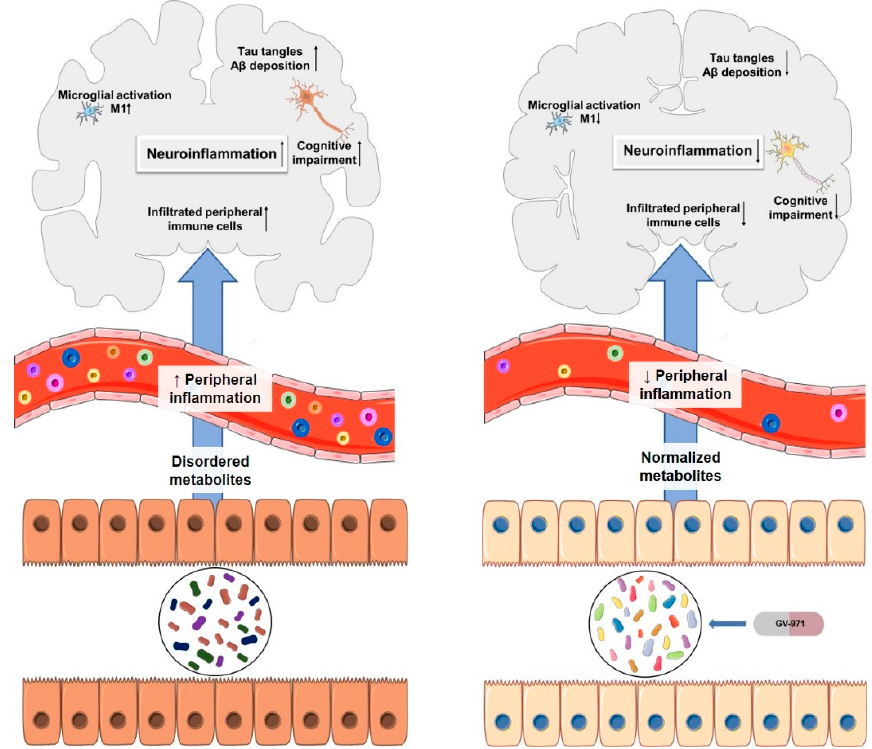
Figure 7. Association of AD and gut microbiota on the left . On the right , the effects of oral Figure7. AssociationofADandgutmicrobiotaonthe left . Onthe right , thee ff ectsoforaladministration administration of GV-971. Adapted from [64] . of GV-971. Adapted from